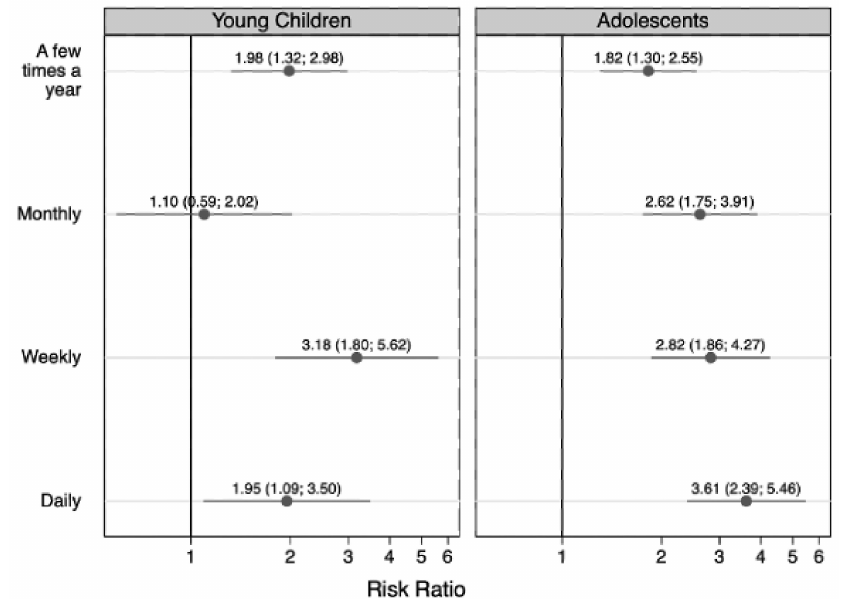
Figure 2. The age-stratified association between having ever resided with someone with a substance use disorder and frequency of children’s anxiety (young children [5–11 years of age] n = 3135; adolescents [12–17 years of age] n = 3507). Symbols indicate relative risk ratios and lines indicate 95% confidence intervals. The referent group is children who never experienced anxiety.